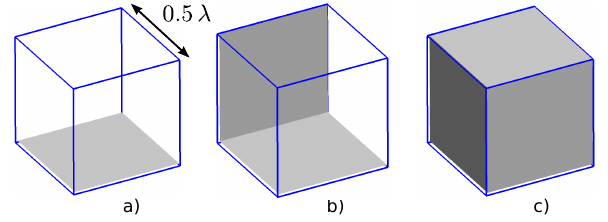
Figure 4: Example geometries in a group with edge length 0 . 5 λ : a) square plate, b) dihedral corner, c) cube.